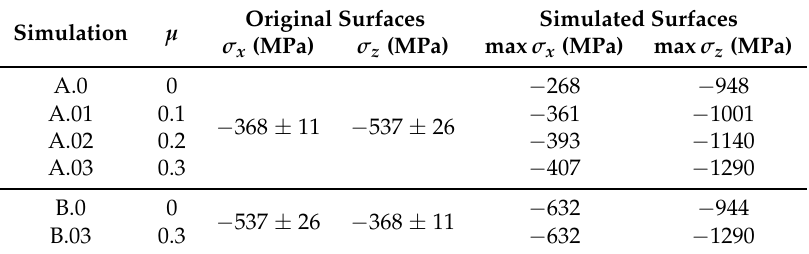
Table 5. Maximum compressive residual stress obtained for each FEM